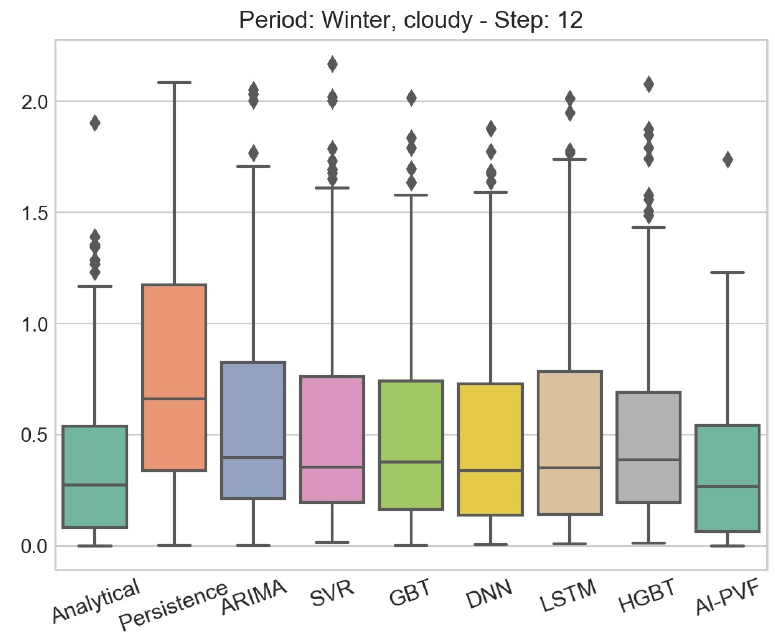
Figure 7. Boxplot of residuals for all PV power generation forecasting models. The data partition examined in this case is the cloudy days subperiod of the winter season and the forecasting horizon is 12 steps